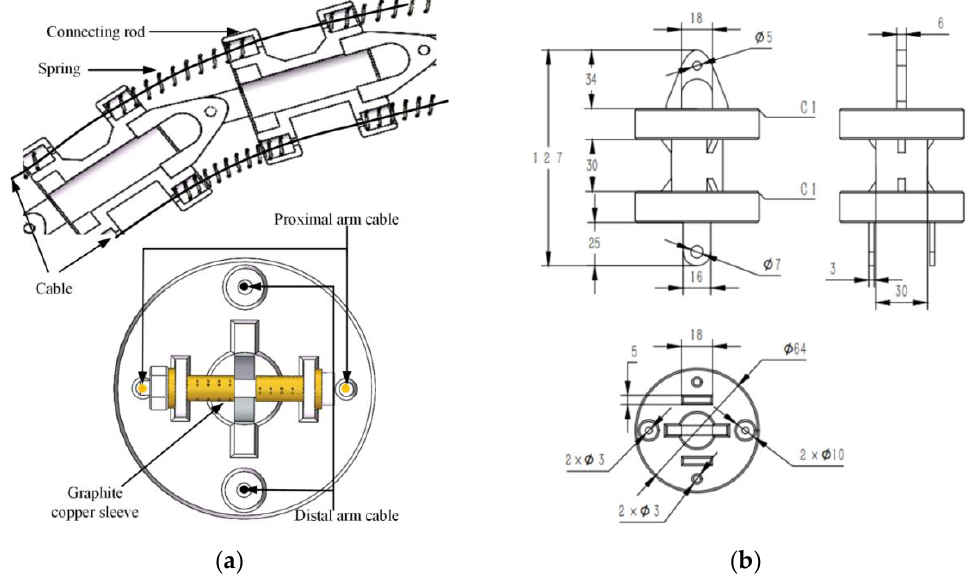
Figure 4. ( a ) The model of two adjacent joints and cable rope arrangement on a disc. ( b ) CAD drawings with different viewing angles of the connecting rod (the unit is mm).